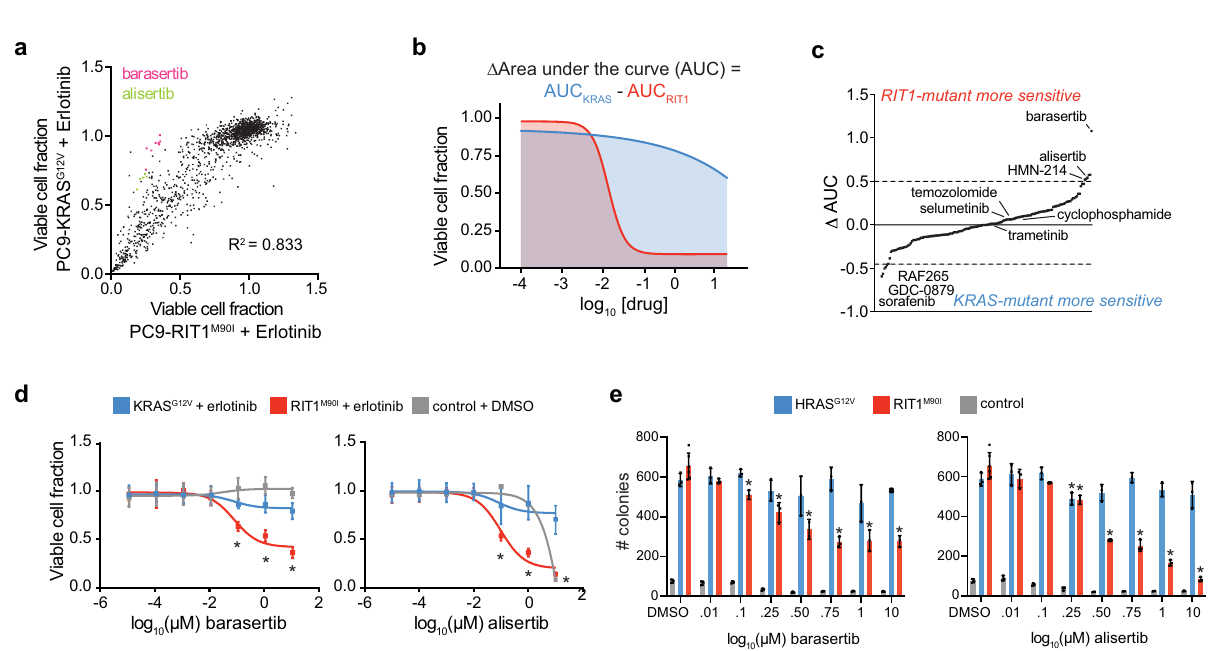
Fig. 5 RIT1 -mutant cells are sensitive to Aurora kinase inhibition. a Drug sensitivity screen of 160 small molecules, 8 doses per compound, in isogenic PC9-RIT1 M90I and PC9-KRAS G12V treated in combination with each test condition and 500 nM erlotinib for 96-hours. Data shown are the mean of two replicates of each individual dose/compound. Viable cell fraction was calculated by normalizing CellTiterGlo luminescence in the test condition to CellTiterGlo luminescence of cells treated only with 500 nM erlotinib. b Schematic illustrating differential ‘ area-under-the-curve ’ (AUC) analysis. c Δ AUC analysis of 160 small molecules generated from data shown in ( a ) and calculated as in ( b ). Each dot represents a different compound. Δ AUC are median- centered and plotted from least to greatest. d Validation of enhanced response to barasertib, left, or alisertib, right. Data shown are mean ± s.d. of n = 16 replicates per dose. * p < 0.05 by unpaired two-tailed t-test. e Soft agar colony formation in NIH3T3 cells expressing RIT1 M90I , HRAS G12V or empty vector (control). Data shown are the mean ± s.d. of n = 3 + replicates for all conditions except for the 0.5 μ M barasertib-treated RIT1 M90I cells ( n = 2). * p < 0.05 by unpaired two-tailed t-test. Source data are provided as a Source Data fi